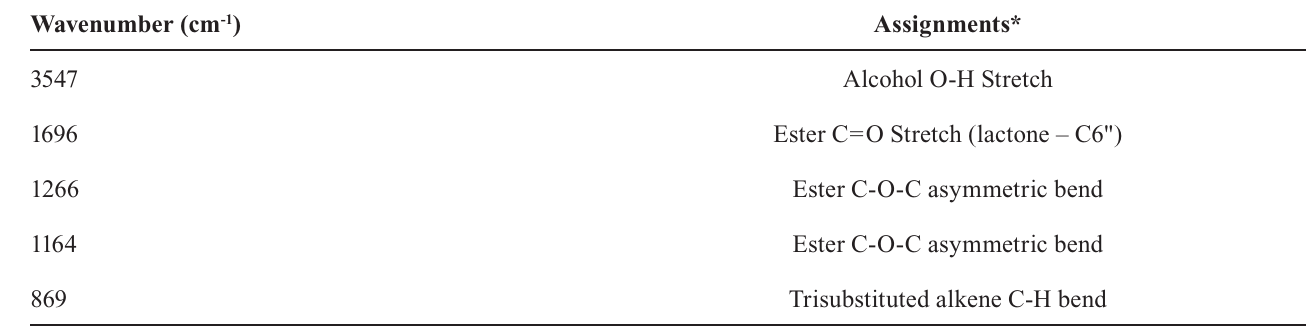
Wavenumber (cm -1